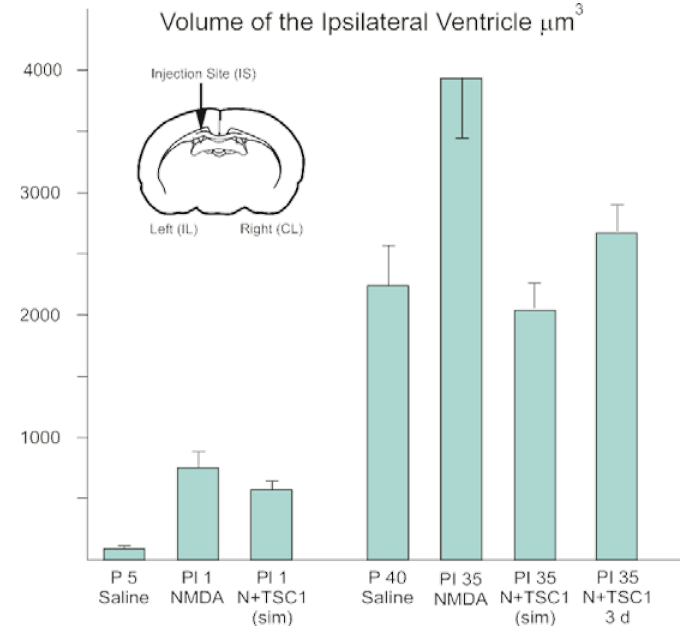
Figure 1. The enlargement of the ventricle after excitotoxicity is decreased with a single dose of TSC1. Seven and 35 days after injection of the specific treatments para-coronal, 28 μm frozen sections were rinsed and mounted for stereological measurements. The volume of the entire ipsilateral (IL) ventricular region was selected and imaged using a 5× objective and the Cavalieri Probe (MBF) obtained in μm 3 . Data represent measurements of 6 adjacent coronal sections per time point from three separate experiments. The diagram shows a coronal section and the arrow points at the injection site (IS). Values are expressed as mean ± SEM of three independent experiments. p ≤ 0.05 vs. controls. All differences